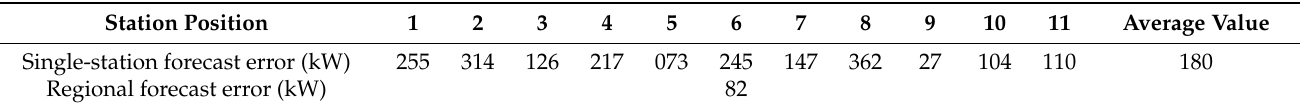
Table 1. Comparison of the site and area forecast error (kW).